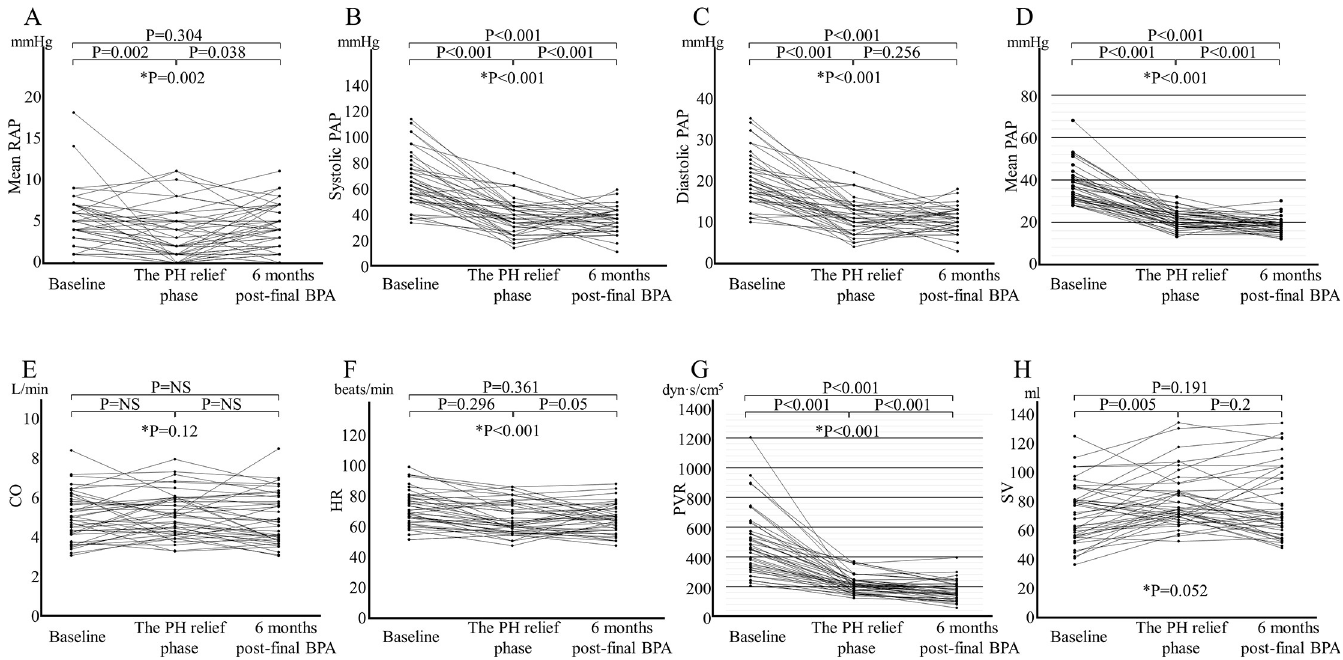
Fig 3. Changes in the parameters of right heart catheterization. (A) Mean right atrial pressure (RAP). (B) Systolic pulmonary artery pressure (PAP). (C) Diastolic PAP. (D) Mean PAP. (E) Cardiac output (CO). (F) Heart rate (HR). (G) Pulmonary vascular resistance (PVR). (H) Stroke volume (SV). In the graph showing brain natriuretic peptide (BNP) and estimated glomerular filtration rate (eGFR), the case represented by the dotted line is a patient on dialysis, with higher BNP level transitions and lower eGFR levels at all time points. The pulmonary hypertension (PH) relief phase was the first-time a mean PAP � 25 mmHg or PVR � 240 dyn-s/ cm 5 was reached before each subsequent balloon pulmonary angioplasty (BPA) session. � P-value of Friedman’s